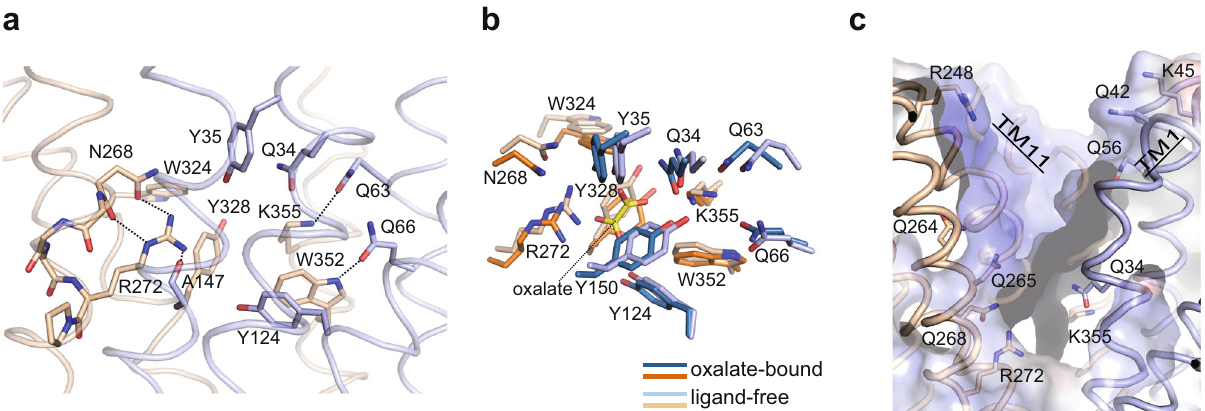
Fig. 3 | Ligand-free outward-facingOxlTstructure.a Close up ofthe binding site in ligand-free OxlT (PDB ID:8HPJ) viewedfrom the same orientation in Fig.2a.The domain colour coding isasin Fig. 1c.The dashed lines indicate potential hydrogen bonds. b Superposition of the substrate-binding site structures of OxlT in oxalate-